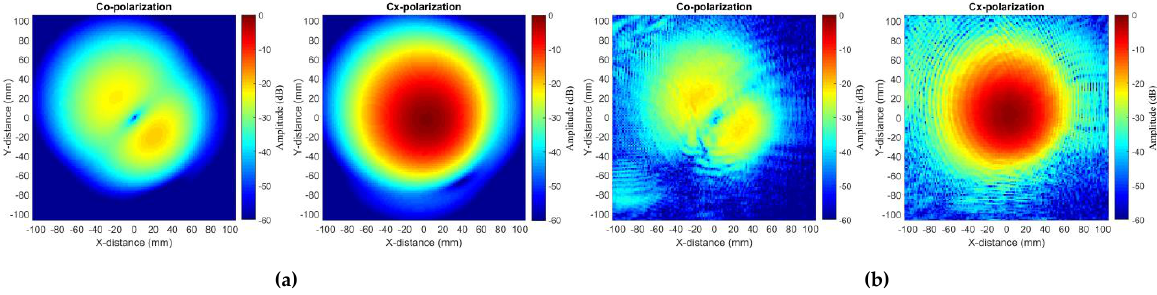
r = π /2: ( a ) E-plane; ( b ) H-plane.